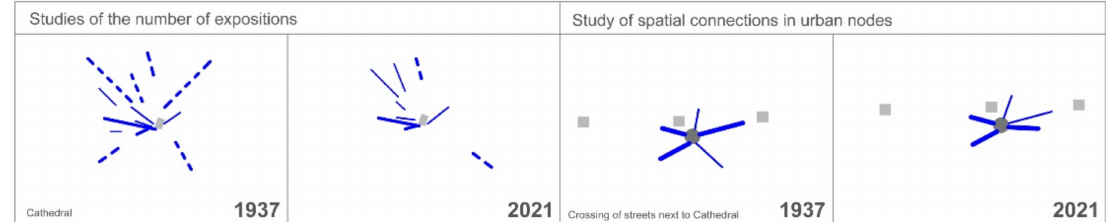
Figure 7. Examples of graphic studies over the number and rank of visual expositions of the selected landmark and spatial connections of the exemplary urban node (wide lines—main directions of visual exposition; slim lines—subordinate directions of visual exposition; continuous lines—direct visual expositions; intermittent lines—indirect visual expositions. On the right: wide lines—main connections; slim line—subordinate connections). Prepared by the